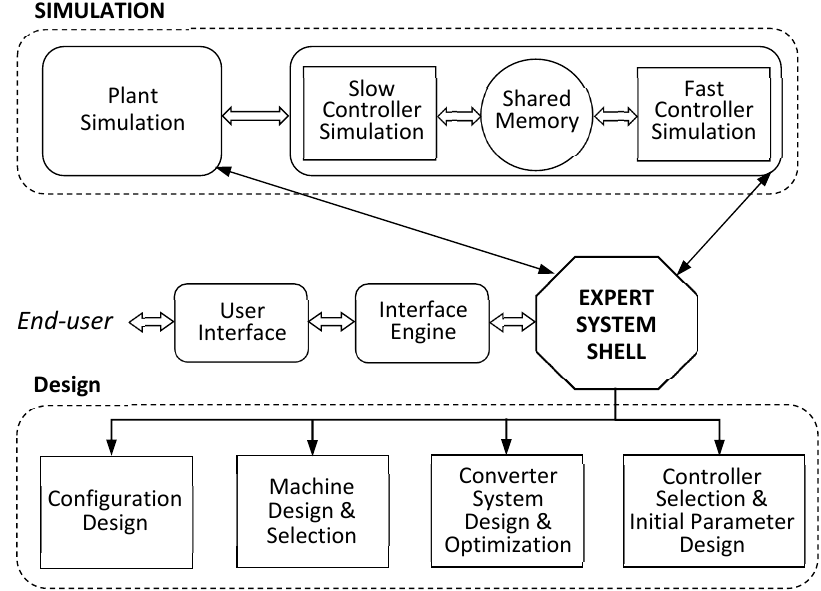
Figure 8. Expert system based automated design for the wind system proposed in [31].